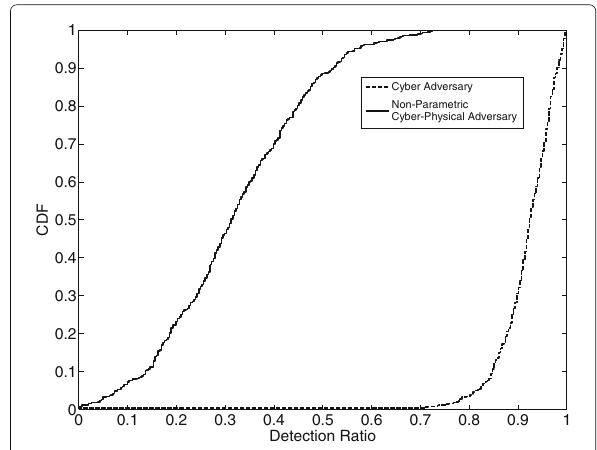
Fig. 4 Cumulative distribution function (CDF) of the detection ratio associated with the χ 2 detector (see Section 3.2), obtained by measuring the DR metric (see Eq. 9) for 200 simulations (both cyber and non-parametric cyber-physical adversary